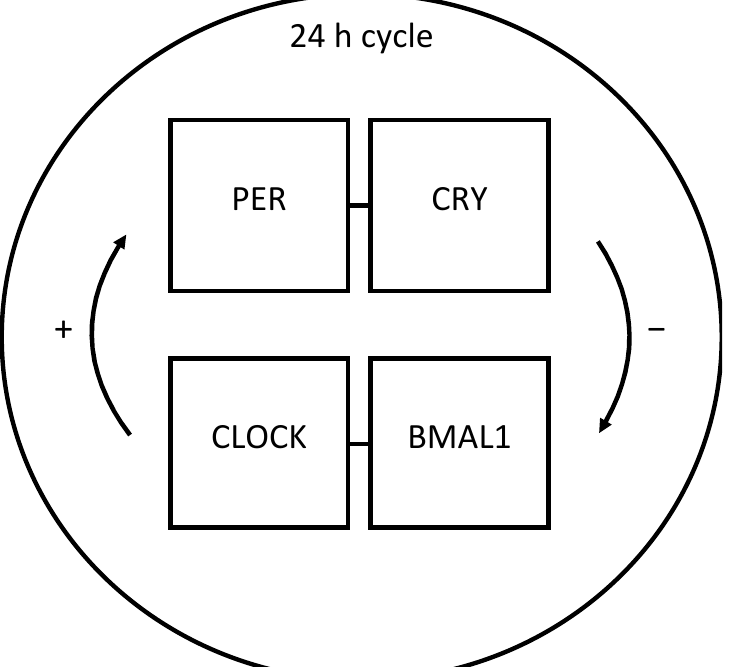
Figure 1. Schematic representation of the biomolecular mechanism of the circadian cycle in mammals: the transcriptional translational feedback loop (TTFL). PER and CRY inhibit the transcription of CLOCK and BMAL1, which in turn are responsible for PER and CRY transcription. The overall cycle lasts about 24 h. PER: period gene product; CRY1: cryptochrome circadian clock 1; CLOCK: Circadian Locomotor Output Cycles Kaput; BMAL1: basic helix–loop–helix ARNT like 1.